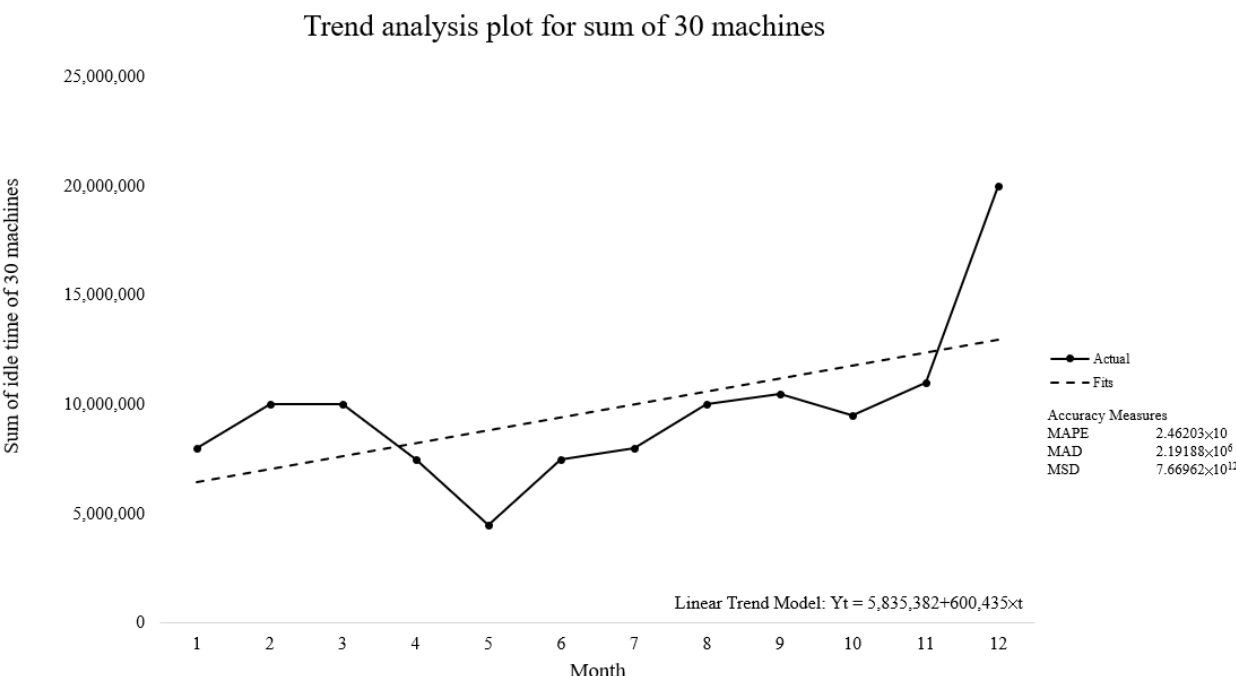
Figure 7. The relationship between idle time and time after the removal of outliers.